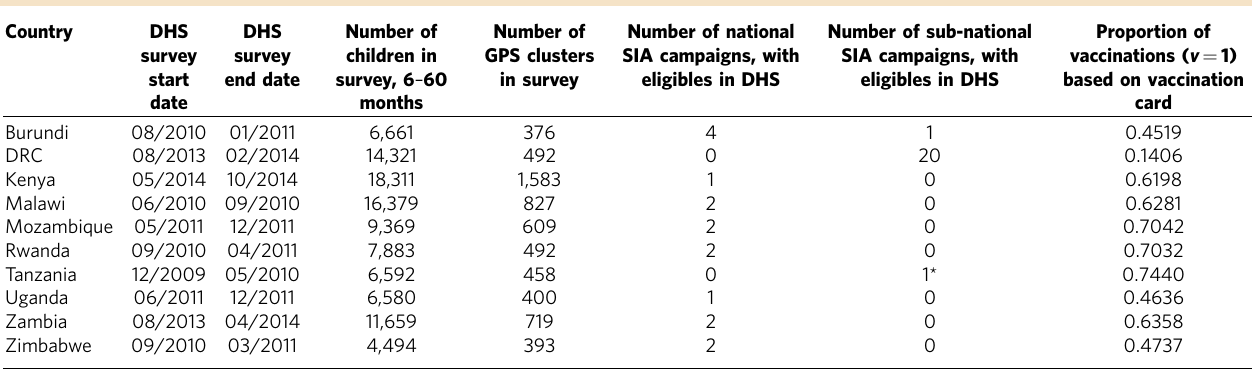
*Tanzania had an SIA campaign in 08/2008–09/2008 that targeted all mainland parts of the country, so this campaign is considered to be